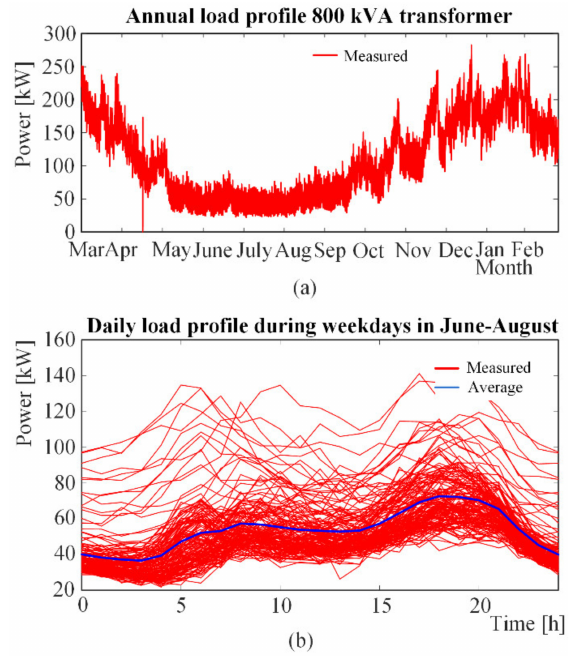
Figure 2. Power consumption ( a ) from 1 March 2018 to 28 February 2019 and ( b ) during weekdays from June to August 2018.